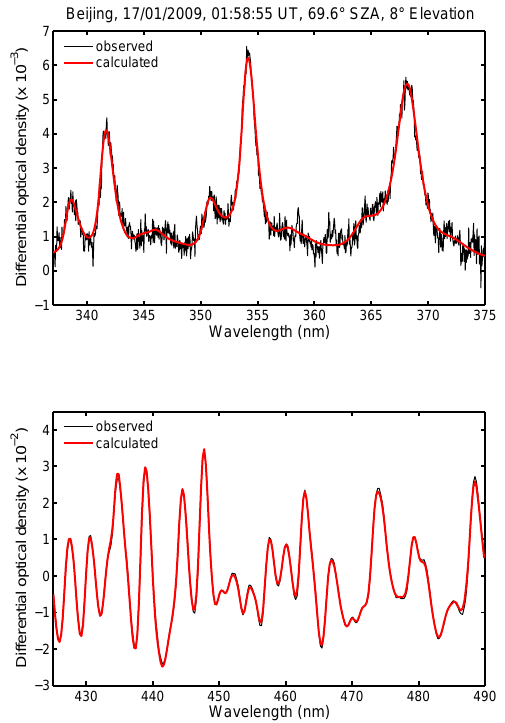
Fig. 1. Example of DOAS fit for HONO (upper plot) and NO 2 (lower plot) at Beijing. Similar DOAS fit results are obtained at Xi-